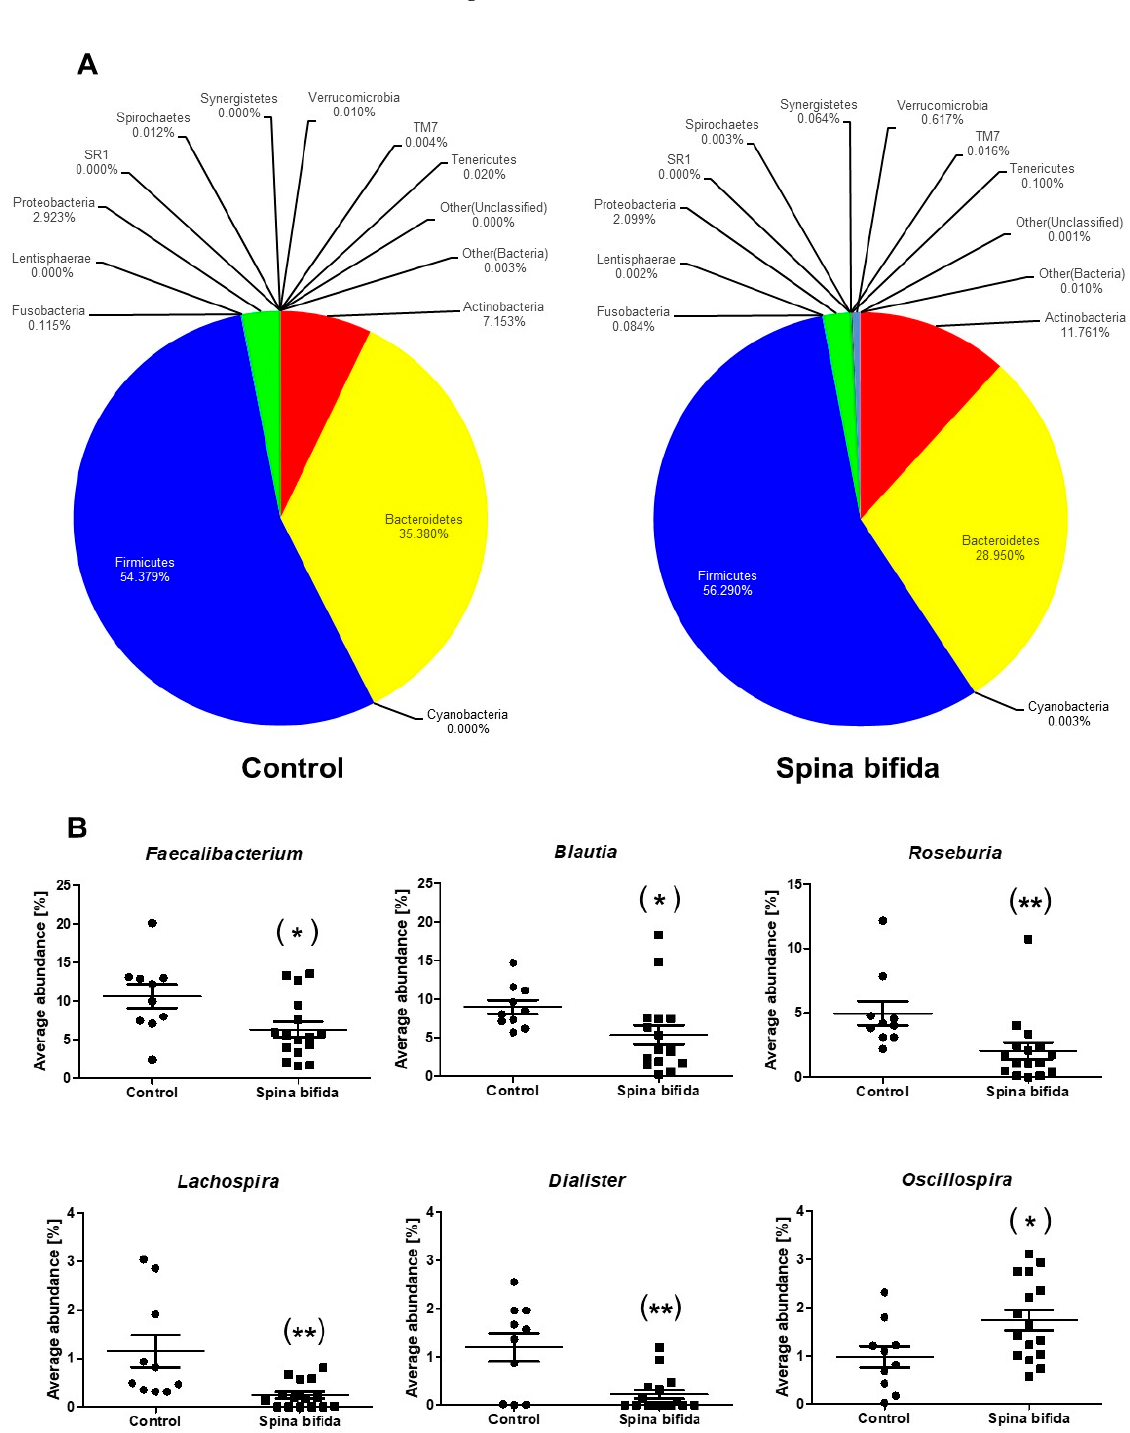
Figure 1. Comparison of gut microbiota in the spina bifida (SB) patients and healthy controls at the phylum level ( A ) and the genus level ( B ). *; p < 0.05, **; p < 0.01 vs. Control. Table 2. Differences between gut microbiota in the SB patients and healthy controls.